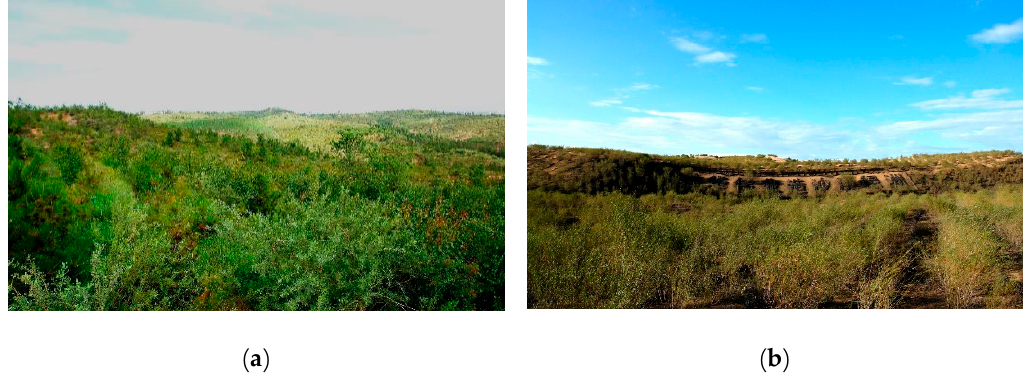
Figure 1. E ff ect of soil and water conservation measures in Shendong Mining Area. Restoration status Figure 1. Effect of soil and water conservation measures in Shendong Mining Area. of subsidence Valley ( a ) and slope ( b Restoration status of subsidence Valley ( a ) and slope ( b ).